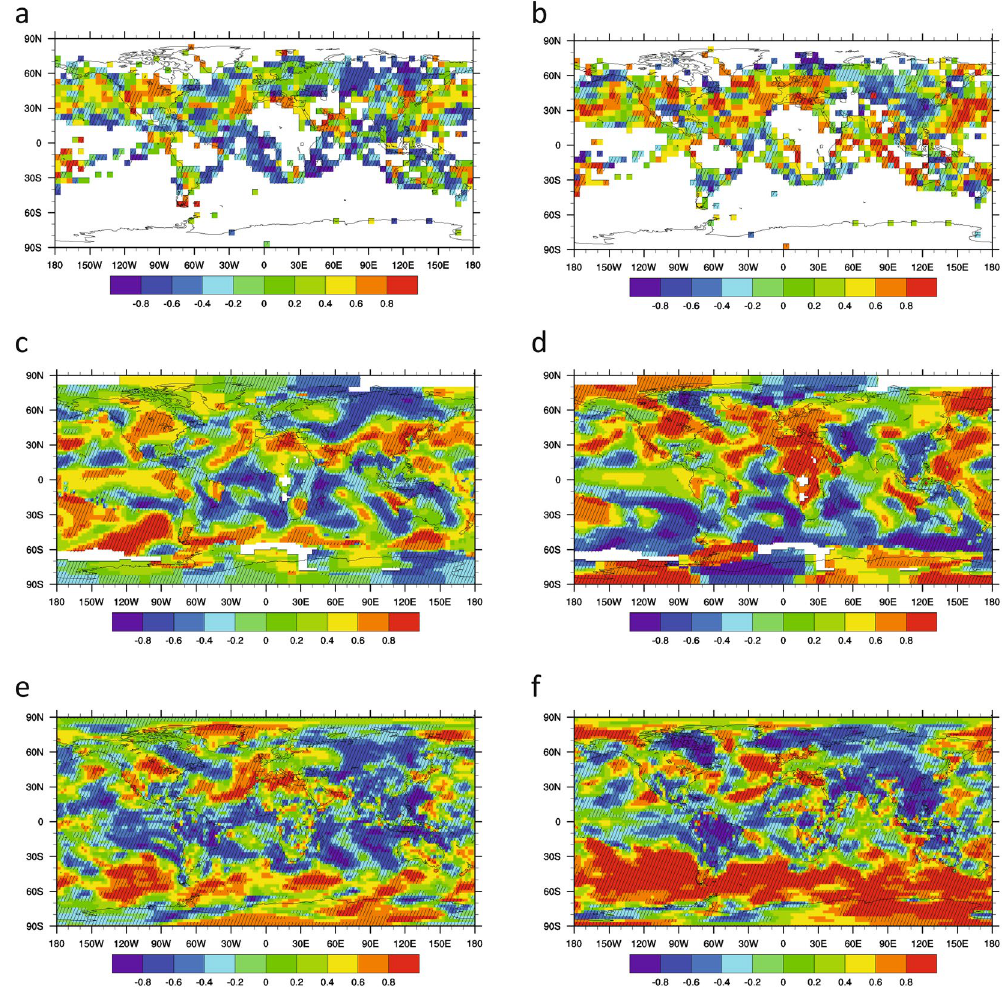
Figure 5. Trends in autocorrelation and variance in different temperature datasets 1957–2002. Monthly temperature datasets processed with filtering bandwidth 10 years and sliding window length 25 years: ( a , b ) HadCRUT4; ( c , d ) GISTEMP; ( e , f ) ERA-40. Trends in: ( a , c , e ) AR(1) and ( b , d , f ) standard deviation, measured as Kendall τ values. Significance at the 90% confidence interval relative to a null model (see Methods) is indicated with cross-hatching. Maps were created using NCAR Command Language (Version 6.2.1) [Software]. (2014). Boulder, Colorado: UCAR/NCAR/CISL/TDD.